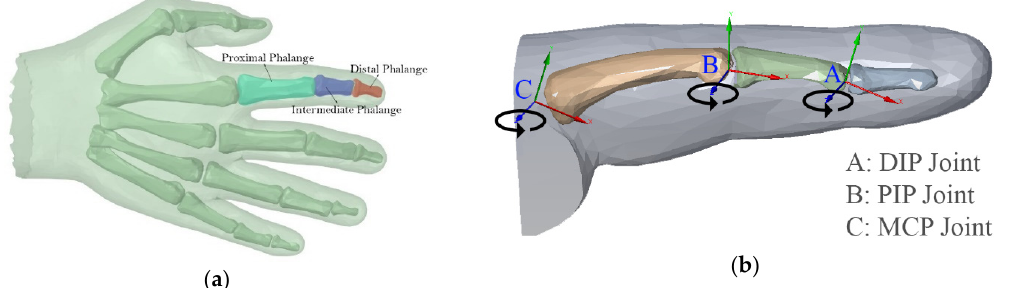
Figure 1. ( a ) FE Model of the human hand; ( b ) FE Model of the Index Finger.